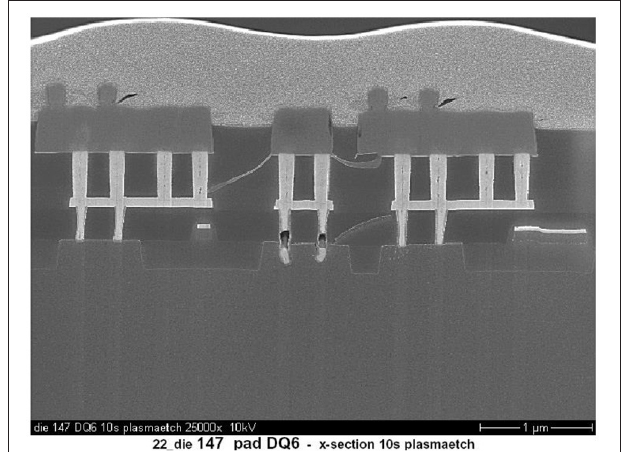
FIGURE 6 | Charged device model (CDM) damage in 100A MOSFET gate oxide (with permission from John Wiley and Sons, Ltd).